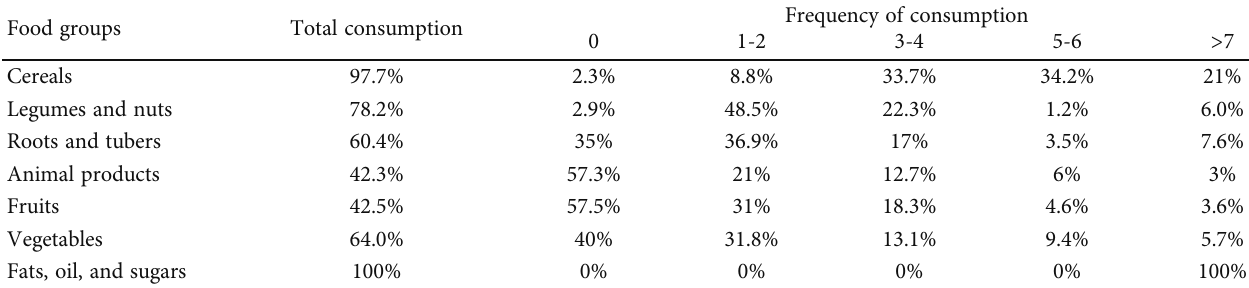
Table 3: Weekly frequency of consumption of various food groups.